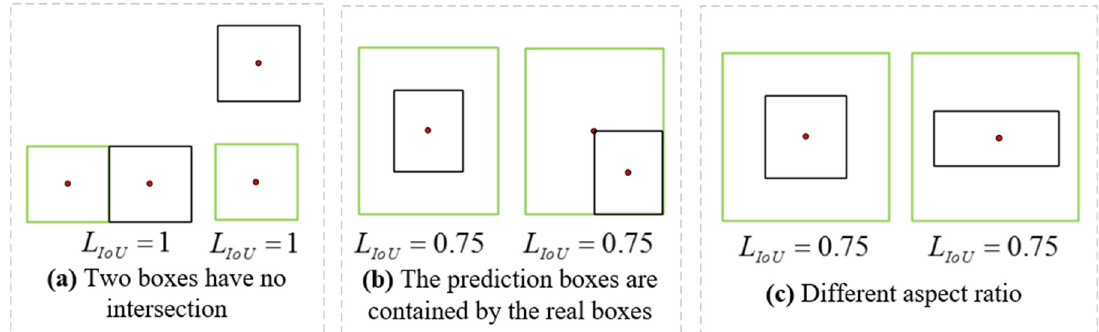
Figure 8. The problems of IoU Loss.